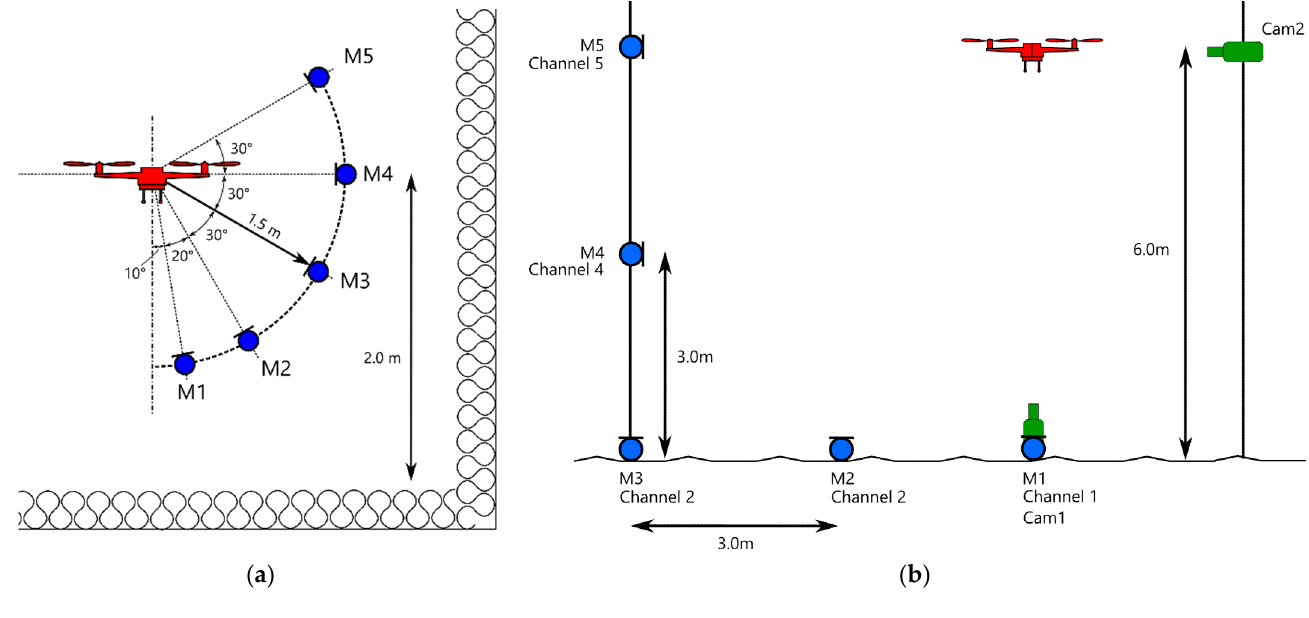
Figure 2. Possible measurement setups for deriving directivity and RPM dependence in the labora- tory ( a ) or outside ( b ). Microphone positions are shown as blue dots. ( b ) additionally proposes two cameras in green that are used to accurately identify the position of the source.